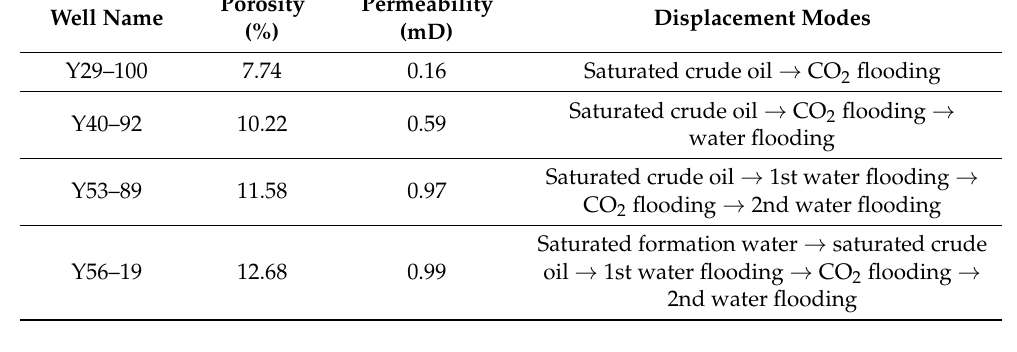
Table 1. Physical properties and displacement mode of the four core samples.